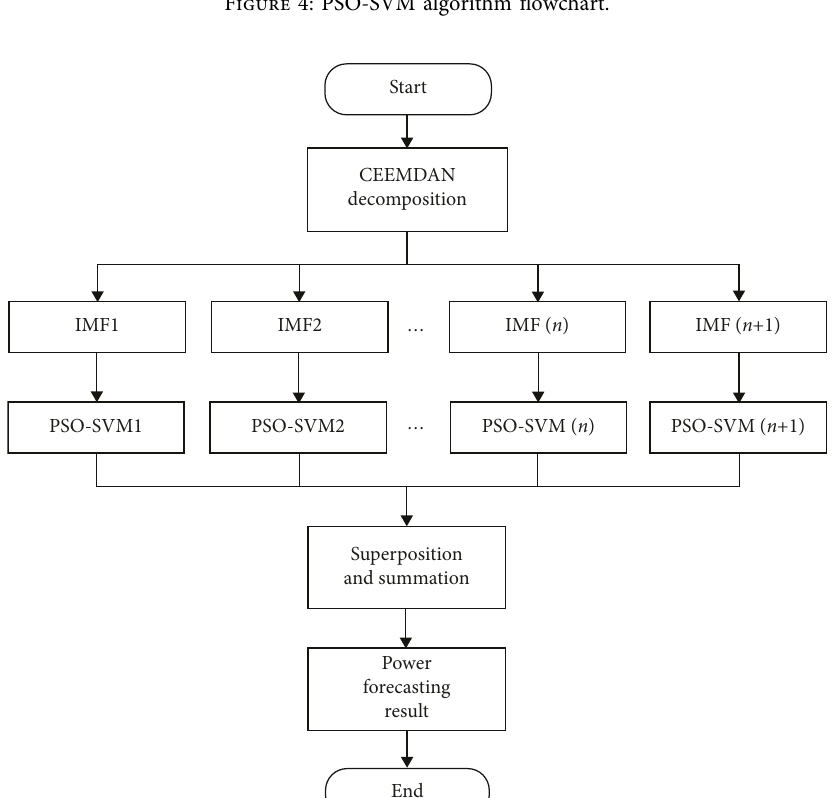
Figure 4: PSO-SVM algorithm flowchart.